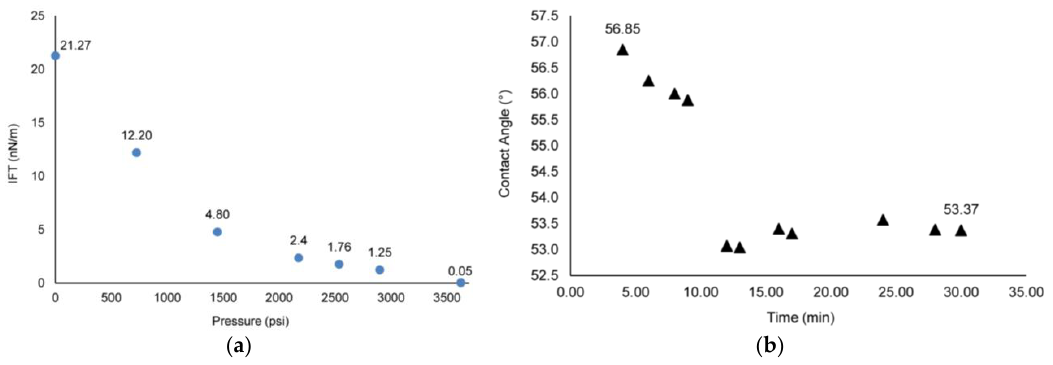
Figure 9. ( a ) IFT of crude oil/CO 2 ; ( b ) Contact angle as a function of time and pressure in a